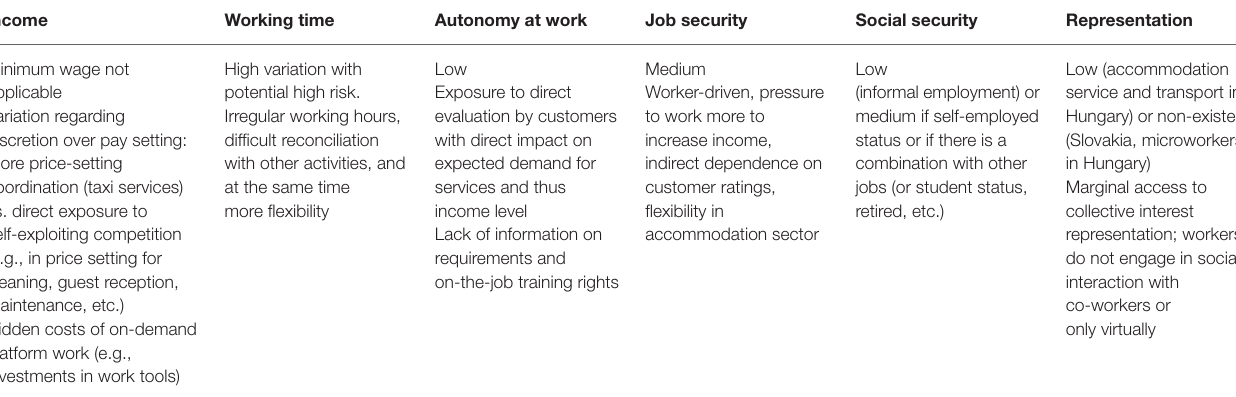
TABLE 1 | Assessment of precarity in six dimensions. Income Working time Autonomy at work Job security Social security Representation Minimum wage not